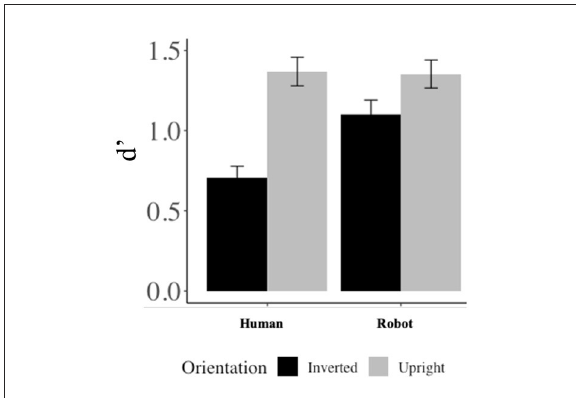
FIGURE4 Results. For human faces, there was a larger difference in recognition performance when comparing faces presented upright and inverted than for